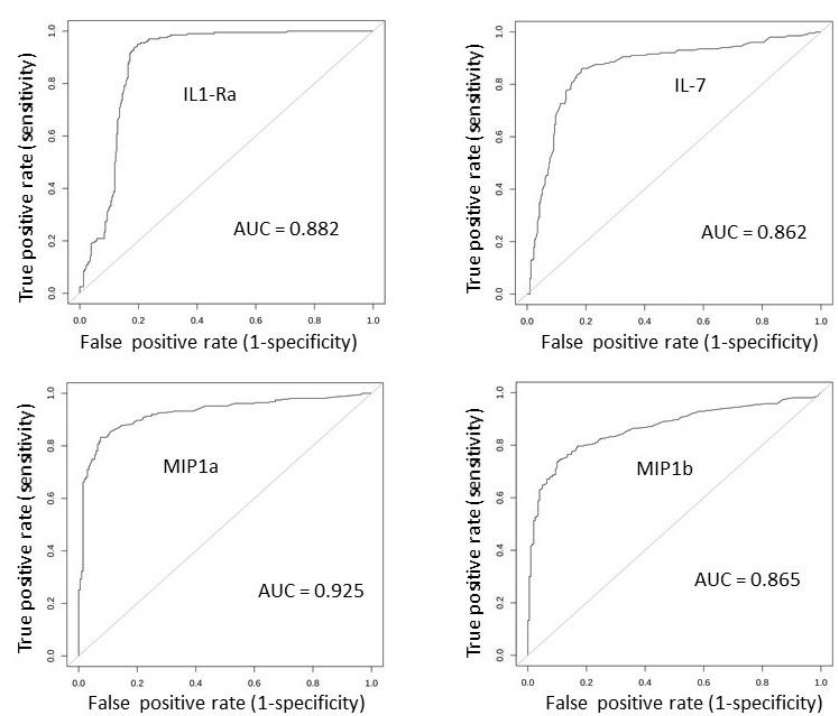
Figure 4. AUC plots of the IL-1Ra, IL-7, MIP-1a, and MIP-1b gene expression in the controls vs. all melanoma samples, for the tissue-expression